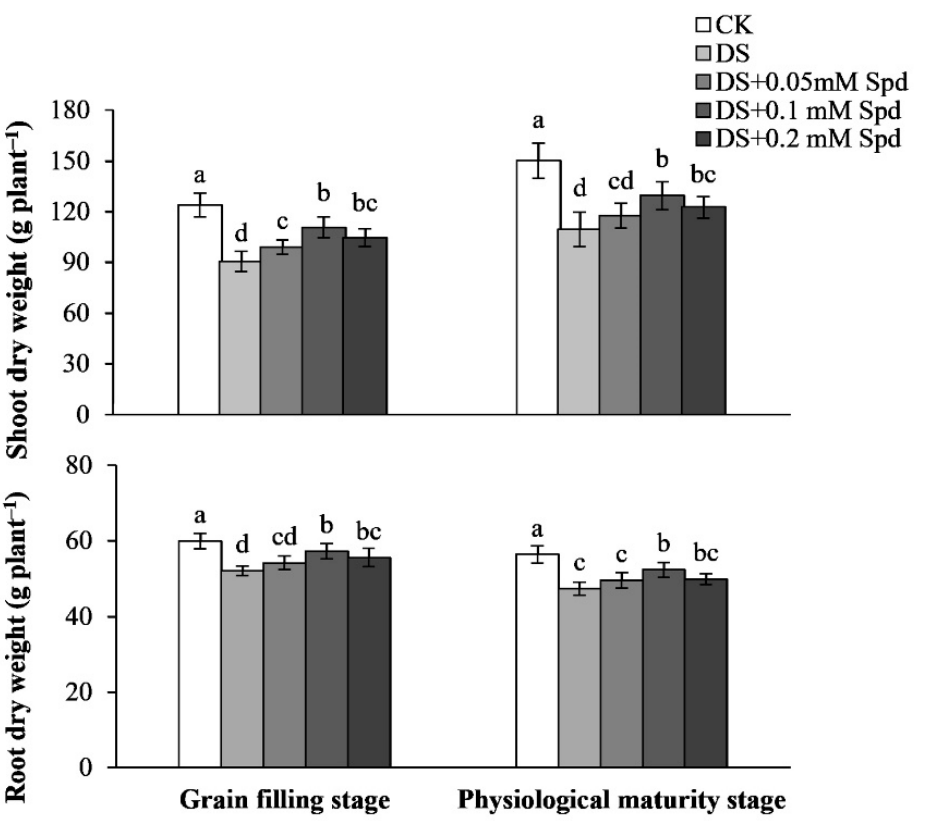
Figure 1. Effects of exogenous spermidine on dry matter accumulation of maize under drought stress. Different letters within the same column indicate significant difference at 5% level.